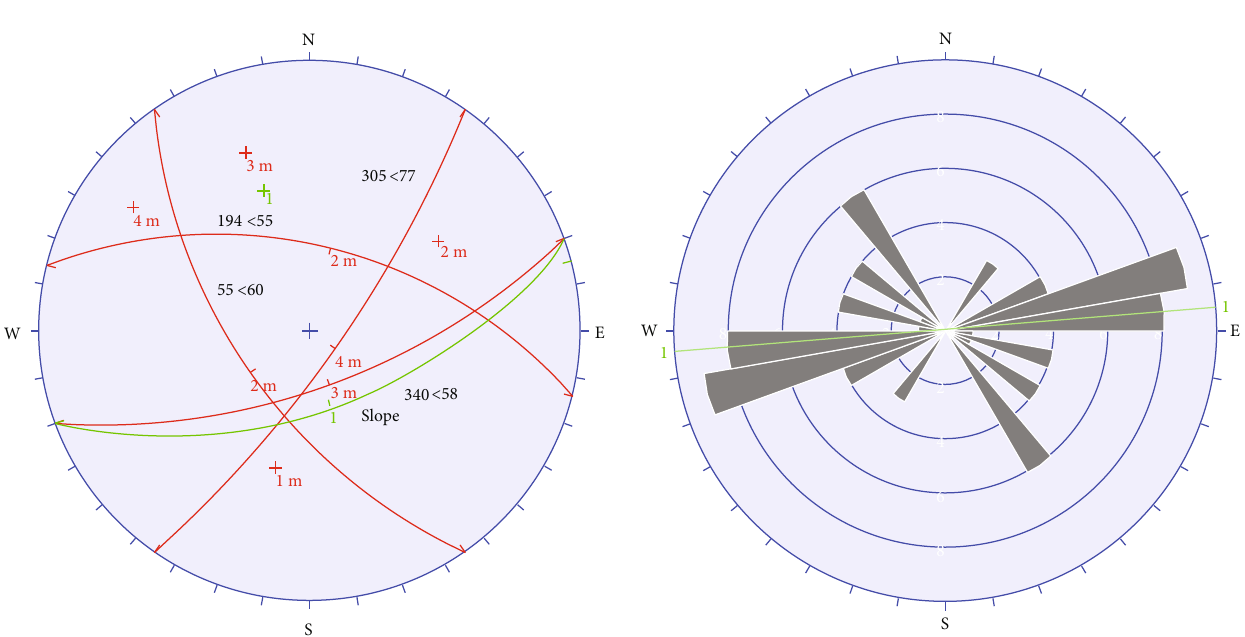
Figure 3: No. 2 observation point stereographic projection and joint rose